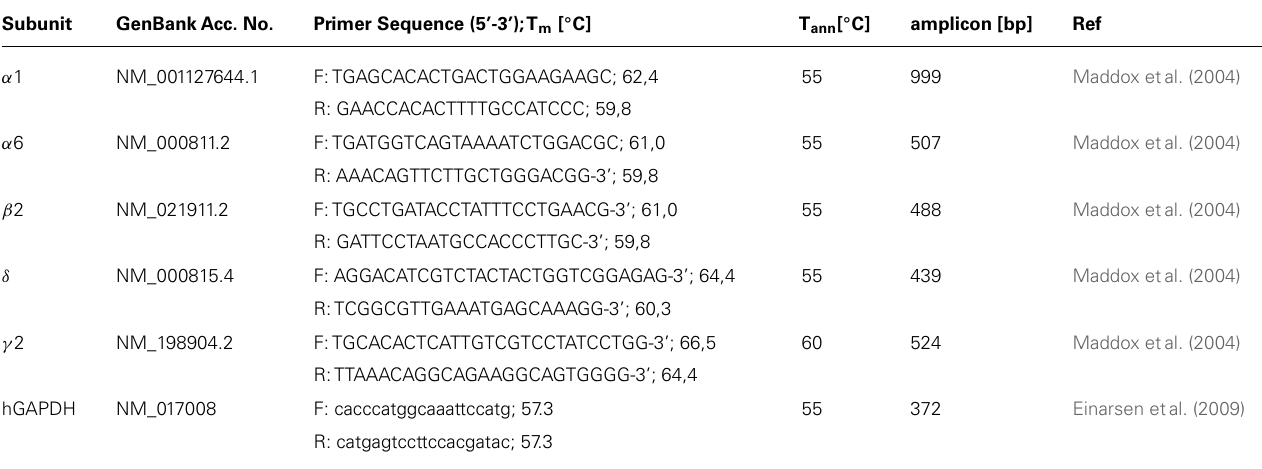
Table 1 | Primers and conditions for reverse-transcription PCR. Subunit GenBankAcc.